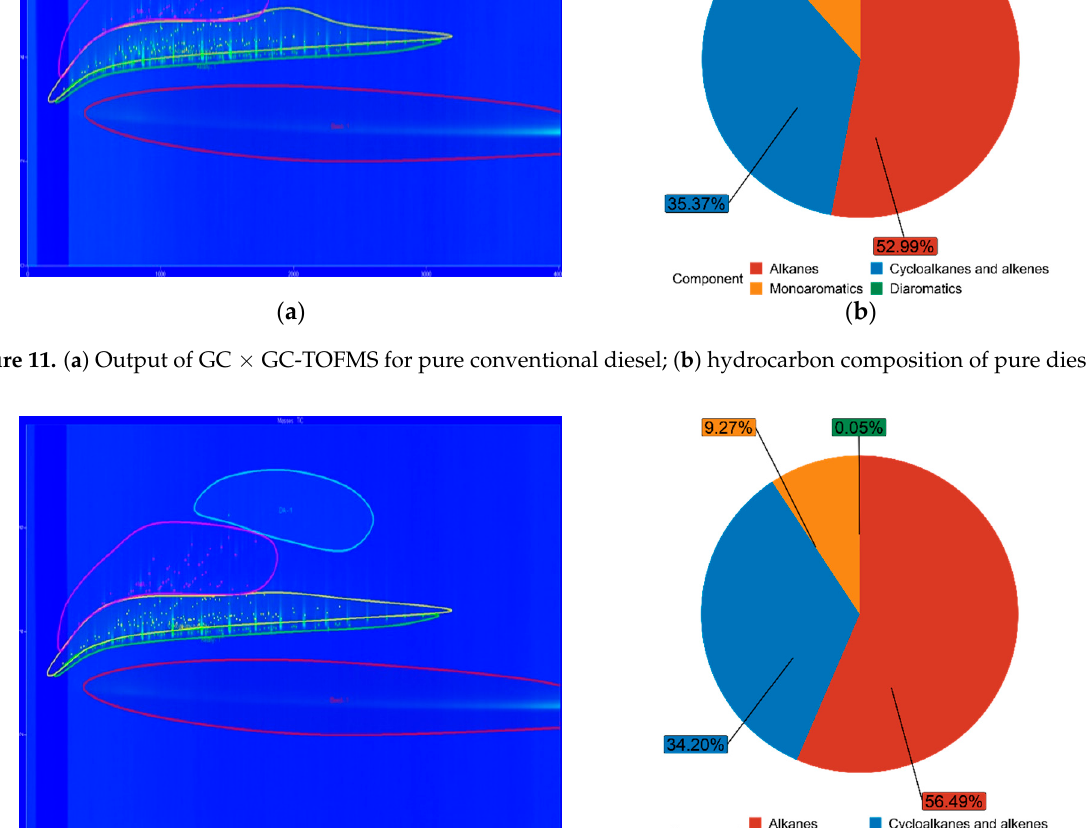
Figure 12. ( a ) Output of GC × GC-TOFMS for 7% FT − diesel; ( b ) hydrocarbon composition of 7% FT-diesel.